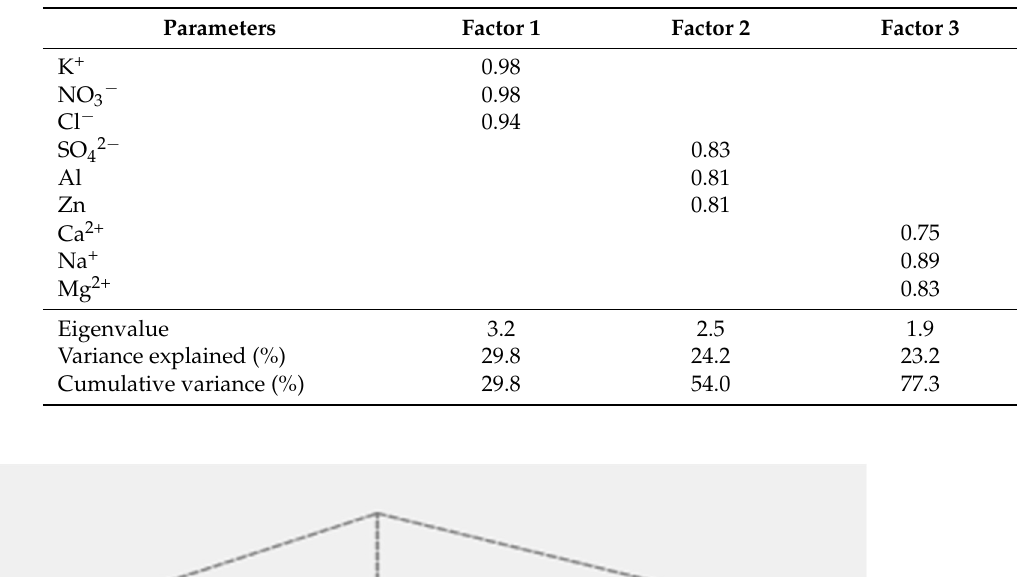
Table 1. Rotated component matrix after varimax rotation of ions and trace metals for present study.